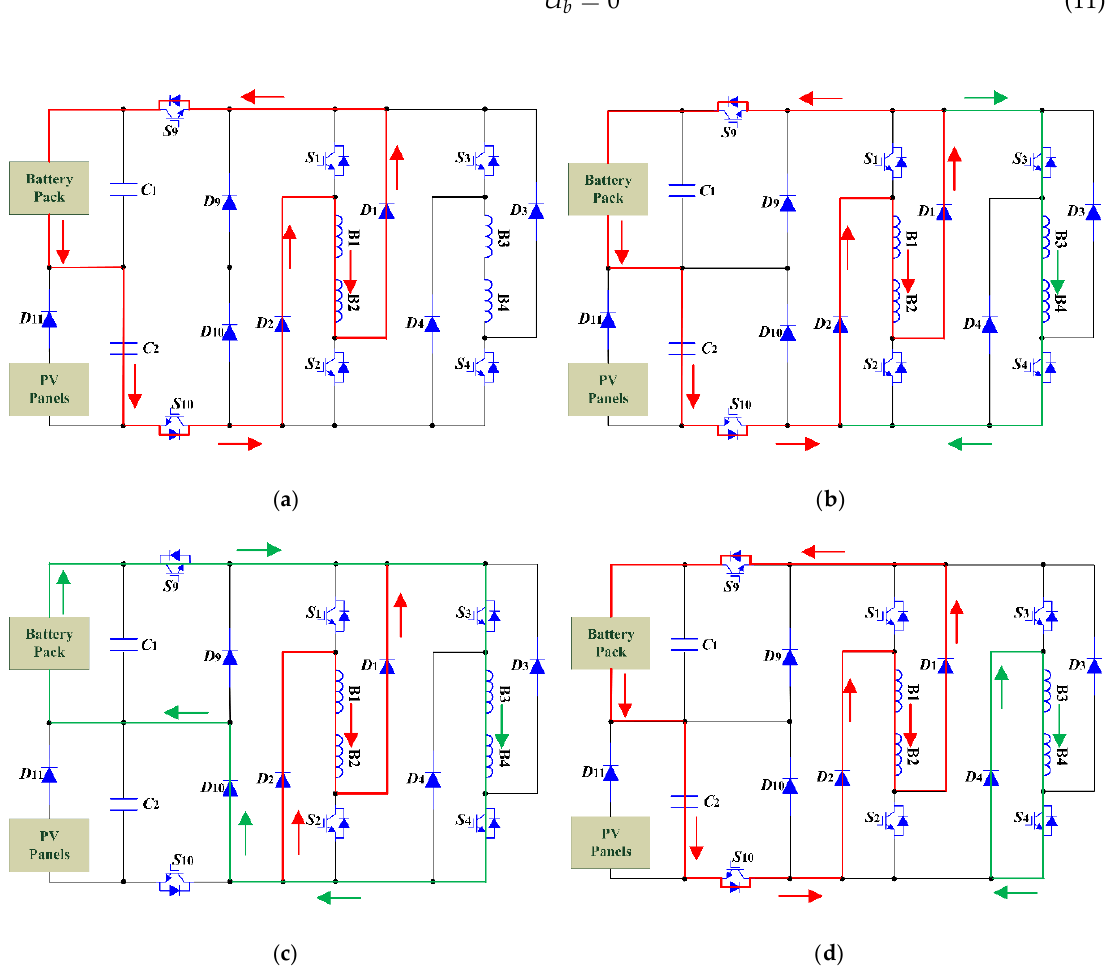
Figure 5. When ϴ off < ϴ < 2 ϴ off − ϴ on , the demagnetization process of the SRM system powered by the Figure 5. When θ o ff < θ < 2 θ o ff − θ on , the demagnetization process of the SRM system powered by the battery pack. ( a ) Stage 1. ( b ) Stage 2. ( c ) Stage 3. ( d ) Stage 4. battery pack. ( a ) Stage 1. ( b ) Stage 2. ( c ) Stage 3. ( d ) Stage